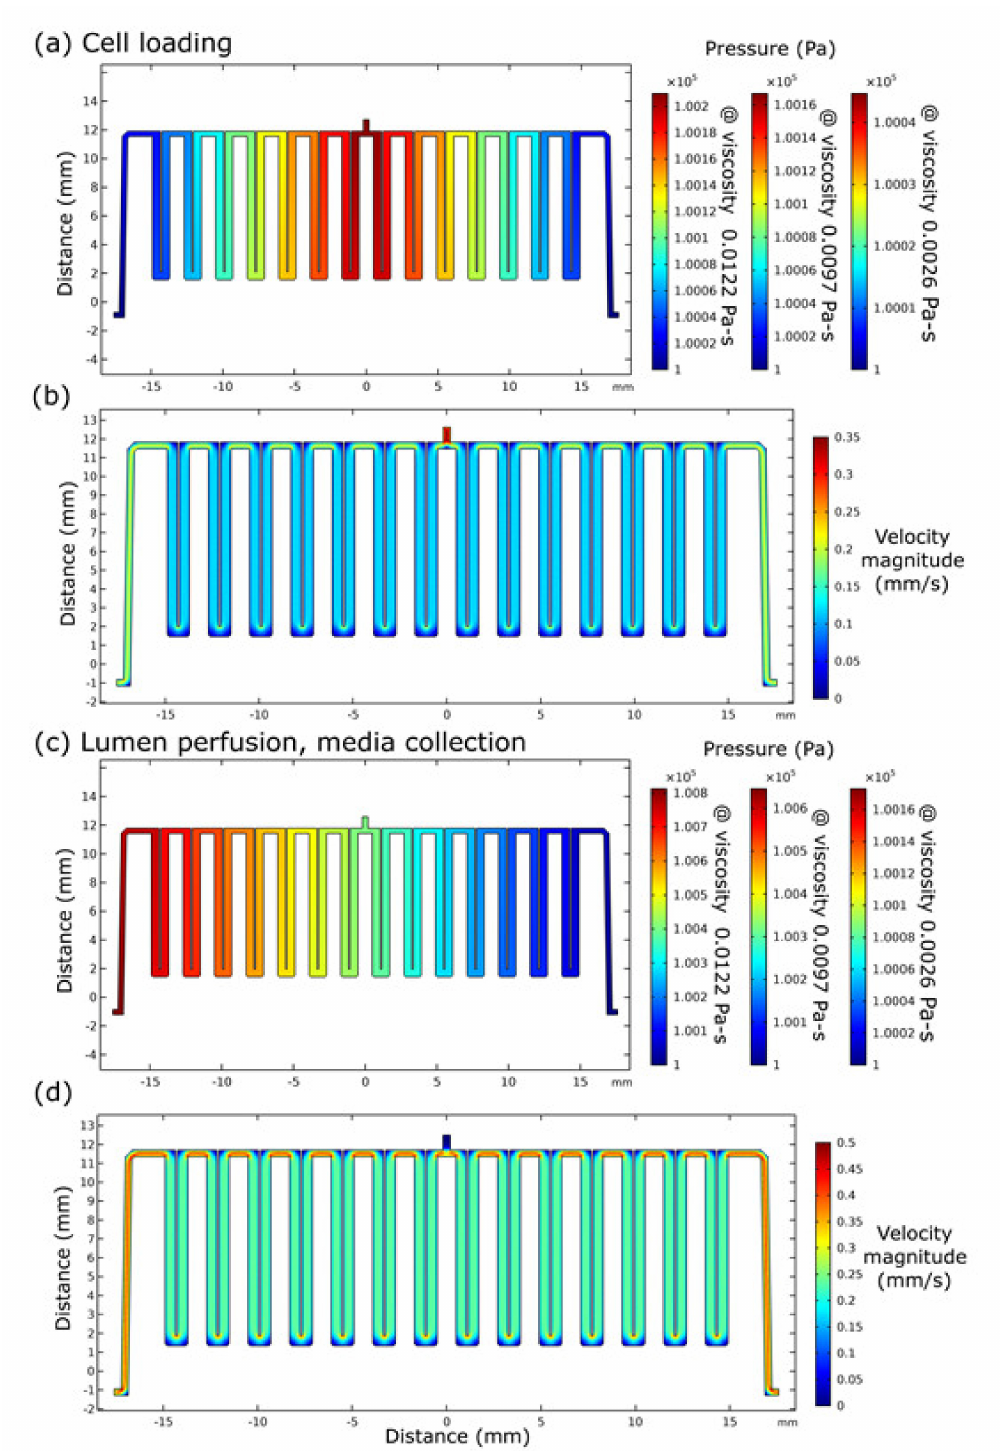
Figure 2. Computational fluid dynamics model velocity and pressure results in microfluidic channels for human microvascular endothelial lumens used for cell culture, irradiation, and media collection ( a , b ). During cell loading, a brief bidirectional flow introduces cells into the serpentine channel microenvironment under reduced velocity and pressure ( c , d ). End-to-end flow during lumen cell culture perfusion and media collection (0.5 µ L/min) occurs with the middle cell loading port sealed; this perfusion system uses a slightly greater fluid velocity and